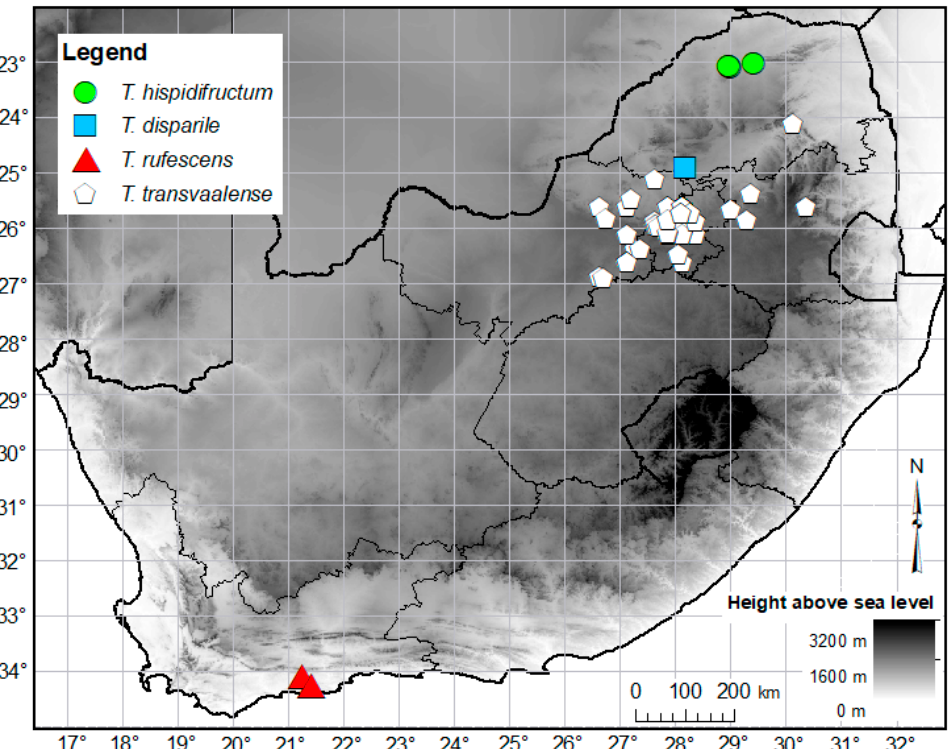
Figure 6. Geographical distributions of Thesium hispidifructum (green circles) and three morphologically similar species, T. disparile (blue square), T. rufescens (red triangles), and T. transvaalense (white pentagons).